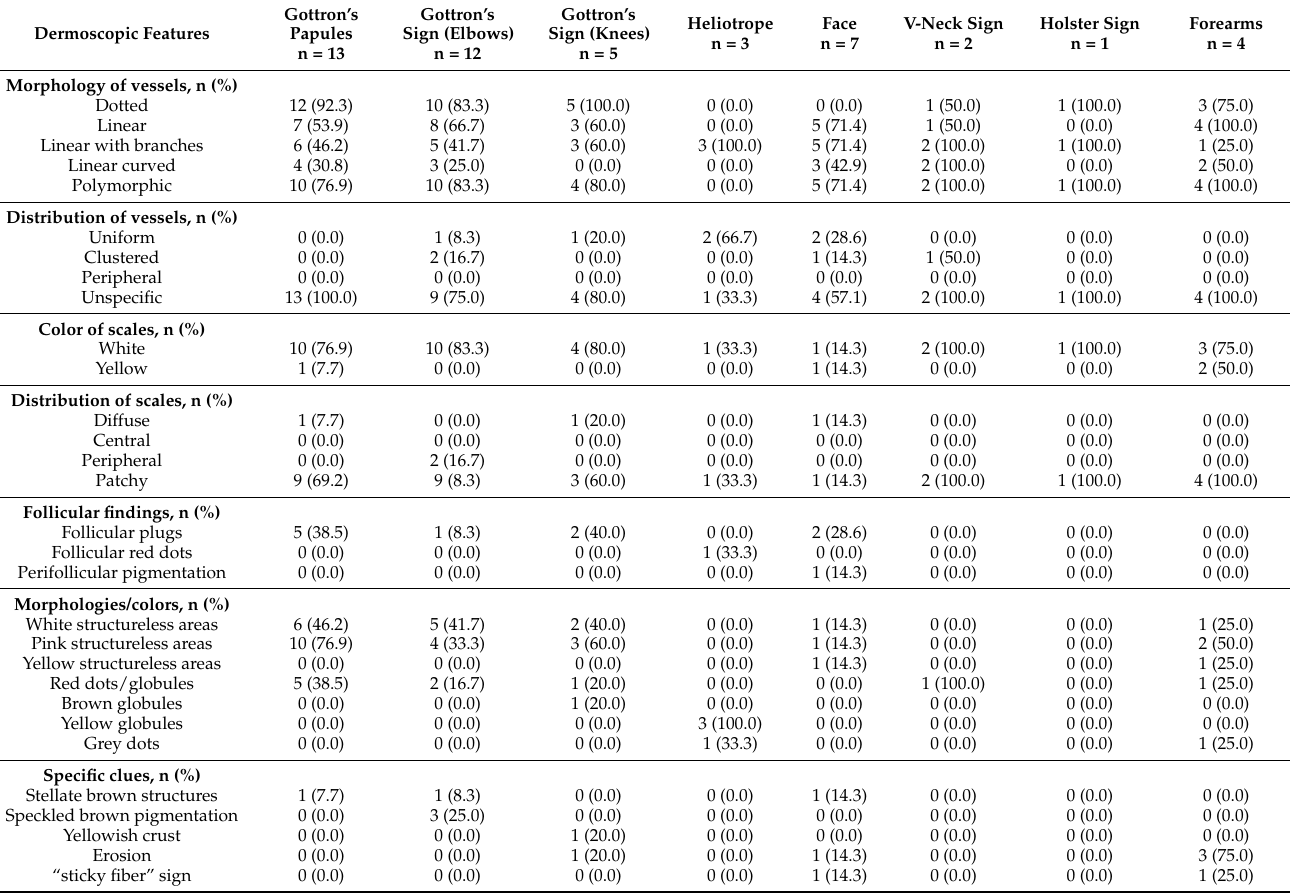
Table 4. Dermoscopic features of the cutaneous lesions in